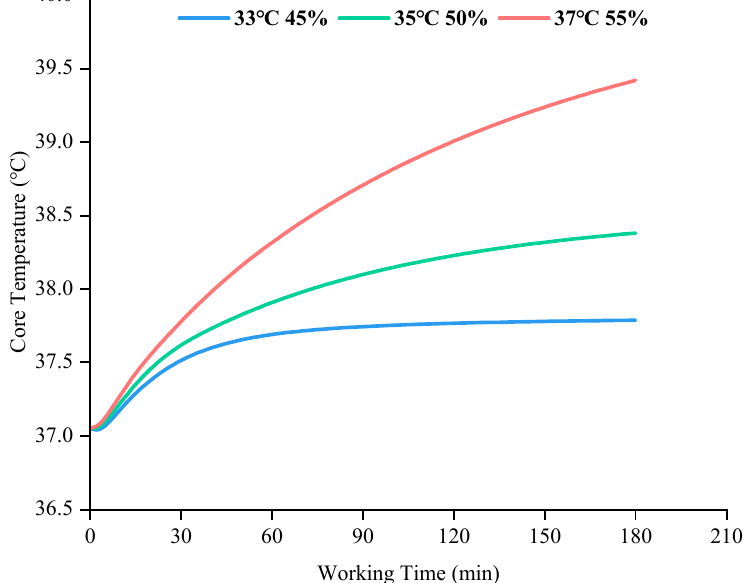
Figure 3. The predicted core temperature of grid workers in different hot environments.